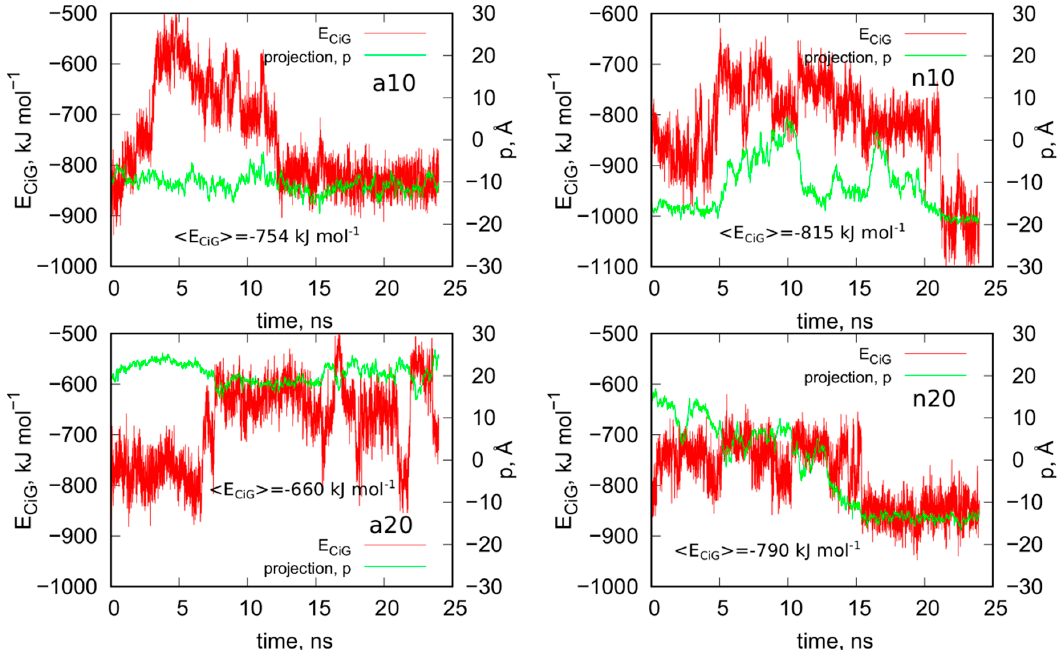
Figure 5. Interaction energy between iG and fCNT, E CiG as a function of time and projection of the center of mass of Gq and iM (taken together) into the CNT axis, p .